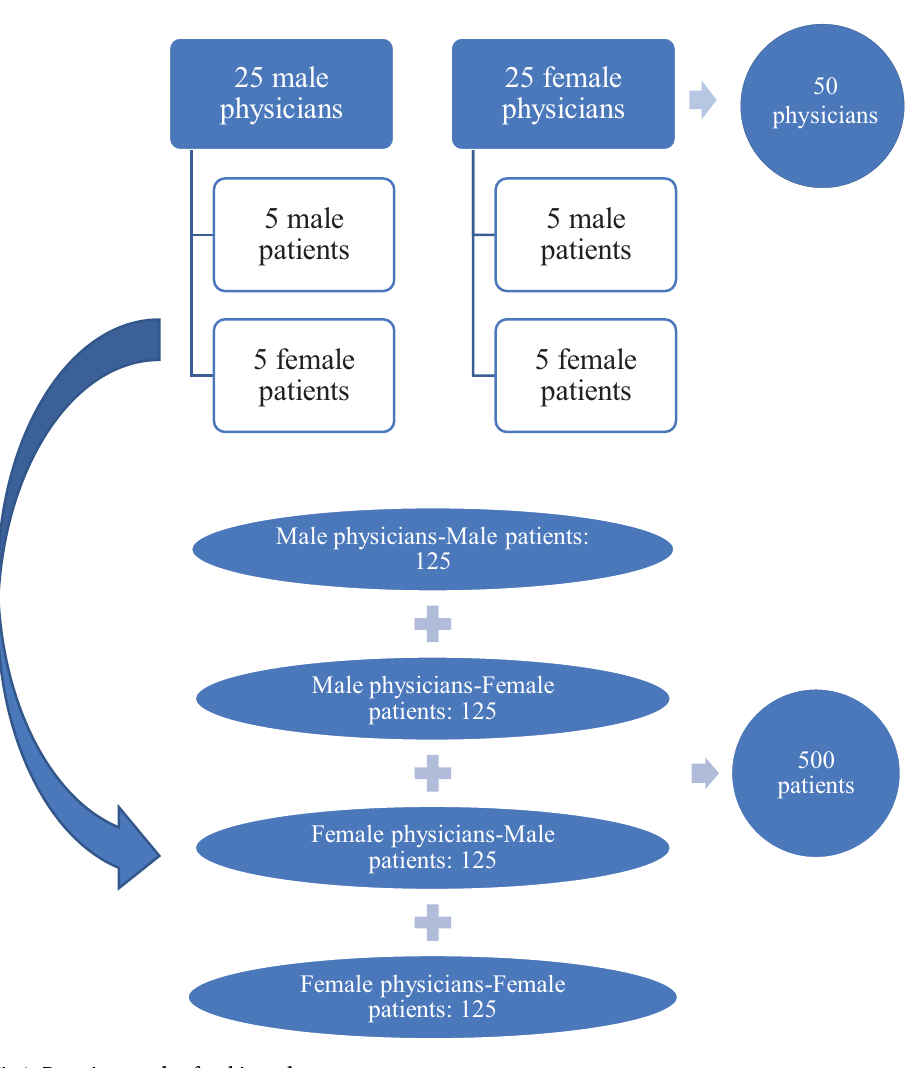
Fig 1. Recruitment plan for this